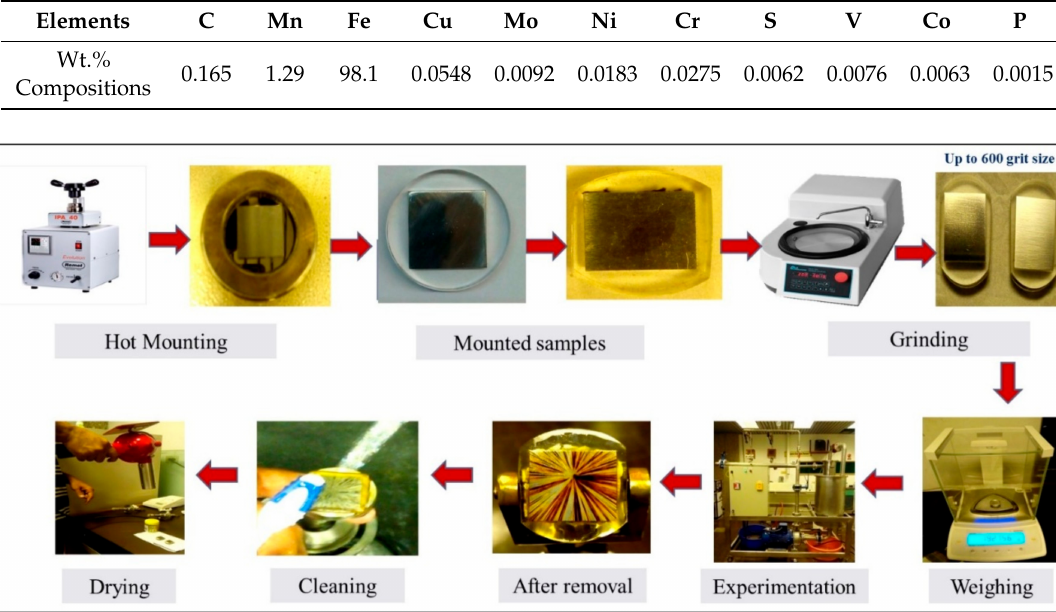
Table 1. Detailed chemical composition of API 5L-X65 carbon steel used in the experiments.